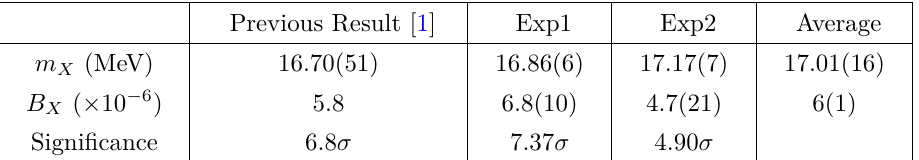
Table 3 . The mass of X particle and branching ratio of 8 Be ∗